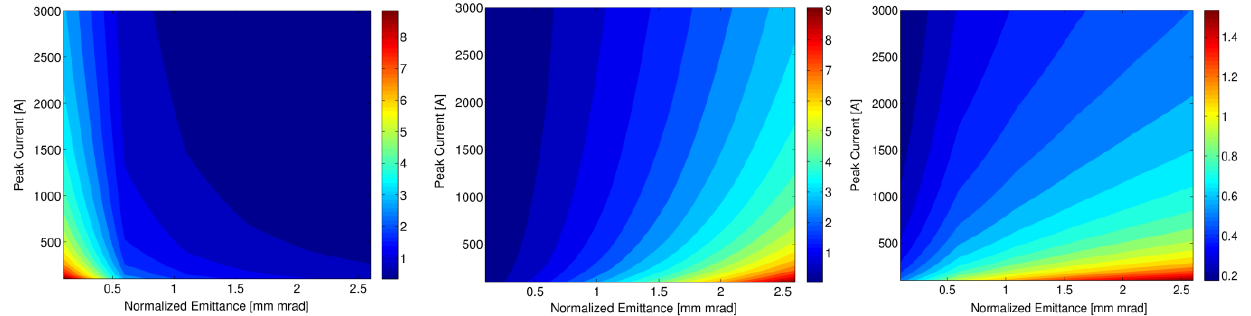
Figure 5. Contour plot of (from left to right)  d ,  current and rms normalized transverse emittance (see Equation (12)). All other beam and undulator parameters are listed in Table